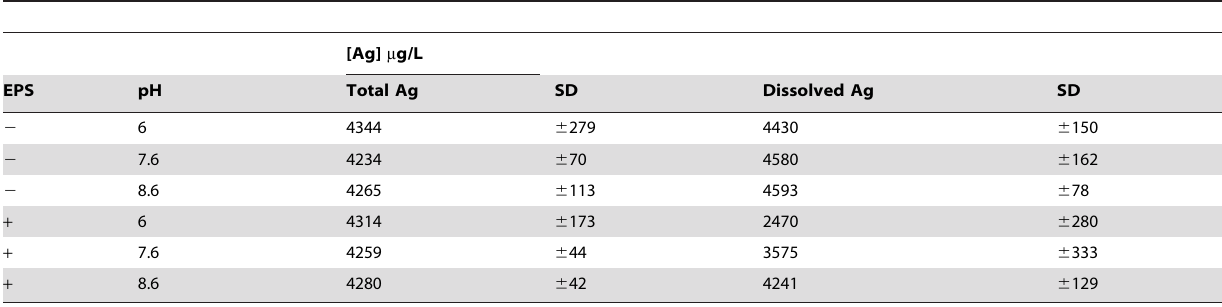
Table 2. Average concentrations of total and dissolved Ag with standard deviations (SD) in AgNO 3 dispersions as determined by ICP-MS of acid-digested samples incubated in light (100 m E/m 2 s) with ( + ) or without ( 2 ) EPS (10 mg DOC/L) for 168